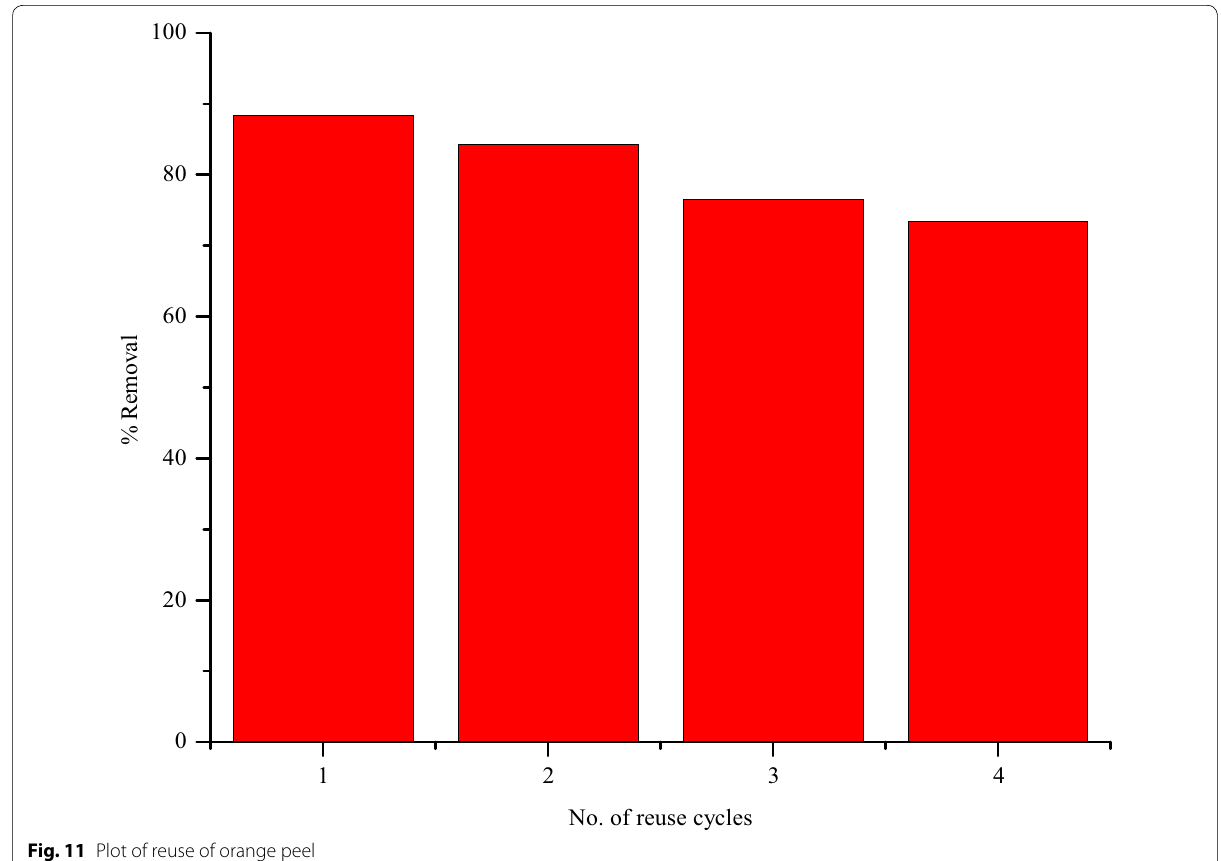
Fig. 11 Plot of reuse of orange